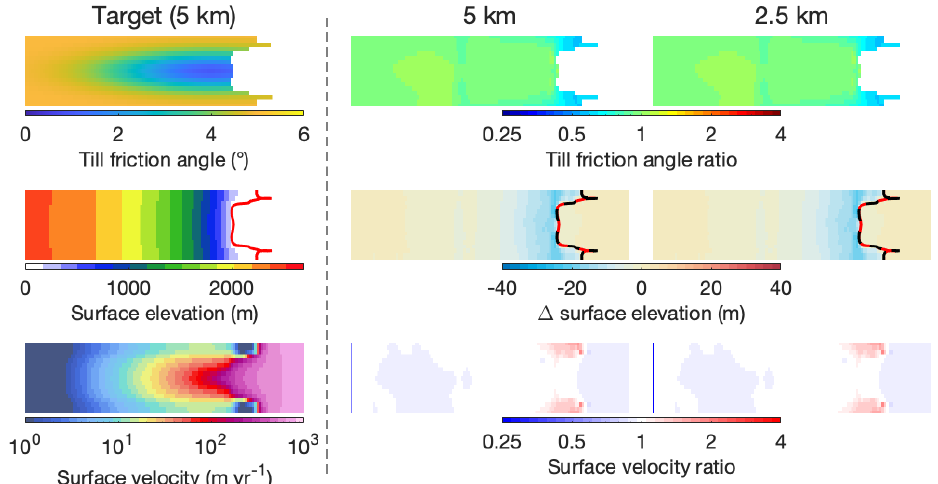
Figure 5. Unperturbed inverted bed roughness, surface elevation, and surface velocity in experiment II at different resolutions, compared to the target. Top row: till friction angle; middle row: surface elevation; bottom row: surface velocity. For the target run (first column), absolute values are shown; for the three unperturbed inversions (second and third columns), errors with respect to the target are shown. The grounding line in the target (inverted) geometry is indicated by a solid red (dashed black)